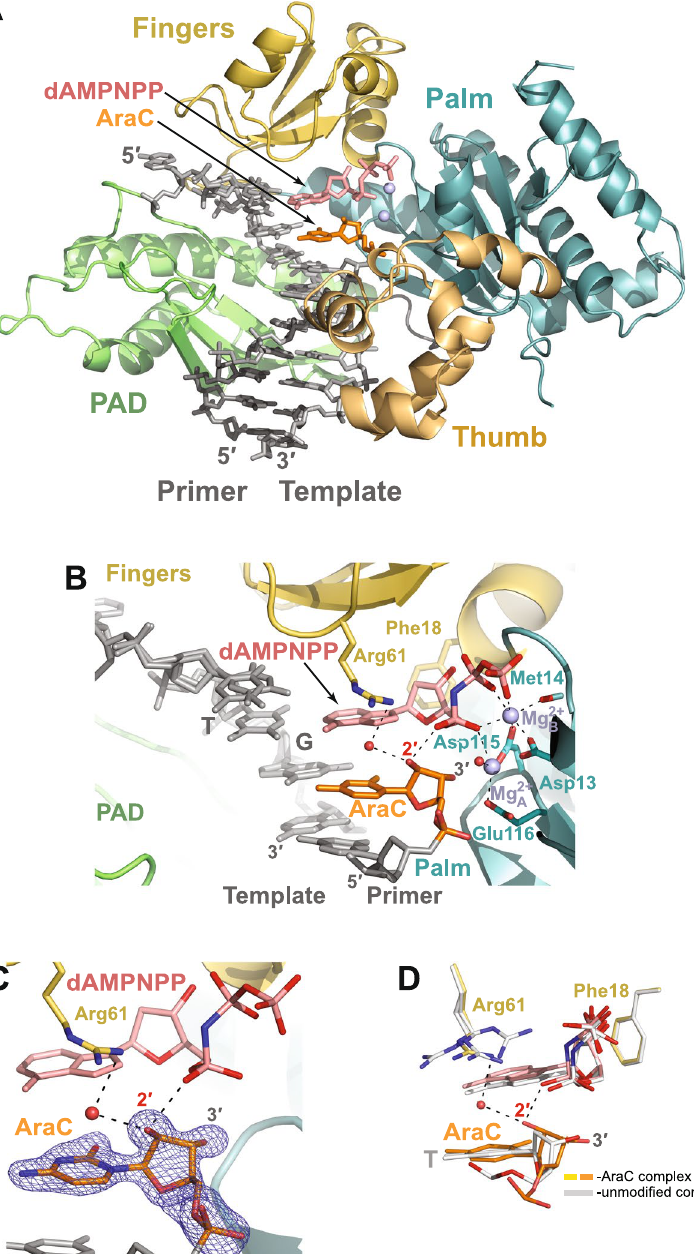
Figure 4. The Pol η AraC extension ternary complex. ( A ) Overall structure of the complex. The incoming dAMPNPP residue is in red. The Mg 2 + ions A and B are represented as light blue spheres. The other colors are as described in Fig. 3. ( B ) The active site of the AraC extension ternary complex. Asp13, Asp115, and Glu116 are the catalytic residues. The water molecules coordinated by the 2 ′ -OH of the AraC and by the Mg 2 + B-ion are shown as red spheres. ( C ) A simulated annealing Fo–Fc omit map (contoured at 3.0 σ -level at 1.75 Å resolution and colored in blue) showing the clear electron density for the entire AraC residue. ( D ) Superposition of the AraC and the unmodified (PDB ID: 3MR2) 27 ternary complexes. The unmodified complex is in white and has an unmodified T residue at the 3 ′ -end of the primer strand; the structures are superimposed by the palm and fingers domains of the polymerase. Both, the AraC and the unmodified T sugar moieties have C2 ′ - endo